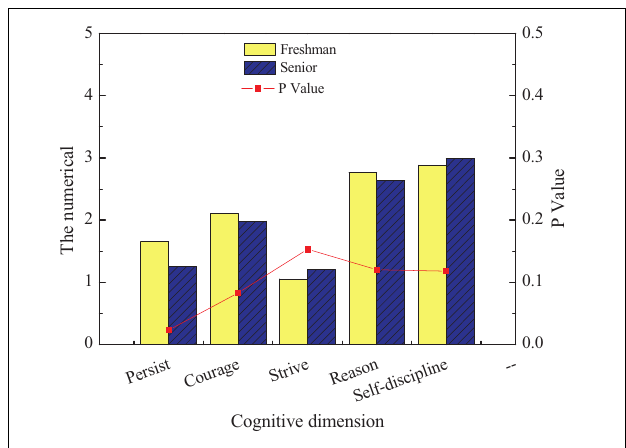
FIGURE 14 | The comparison of entrepreneurial will among students of different